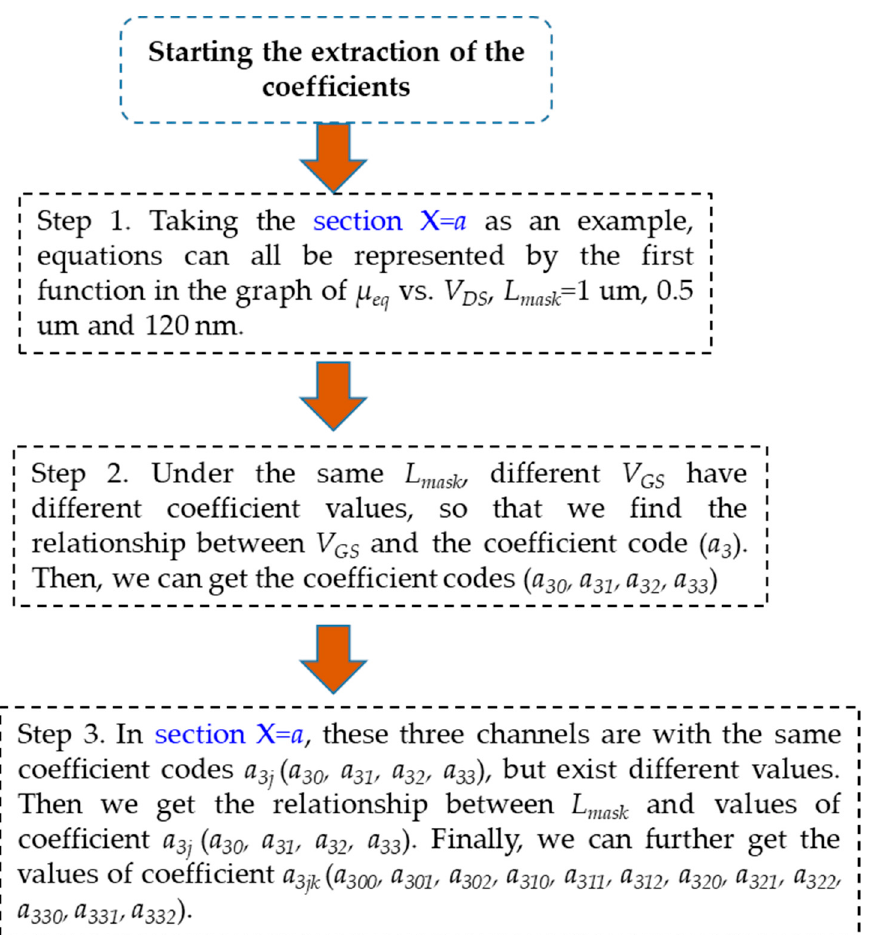
Figure 5. Flow chart for extracting the coefficients of X i and X ij , in section X = a .